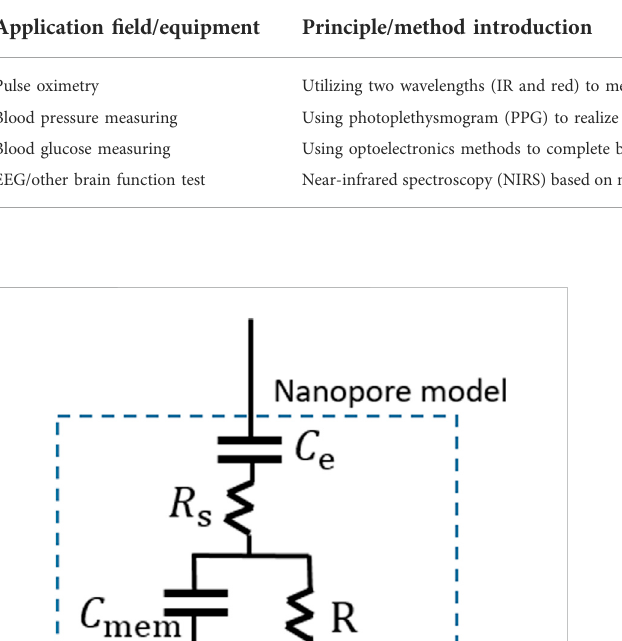
TABLE 1 Applications of TIA in biomedical equipment.